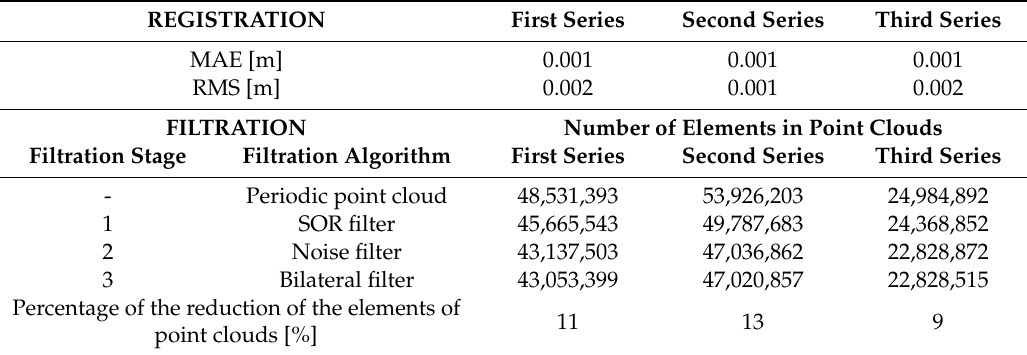
Table 7. Results of TLS data and TLS data filtration. MAE: mean absolute